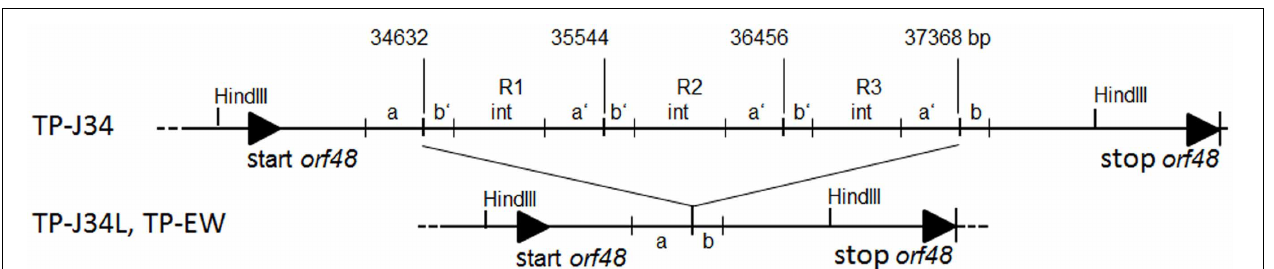
FIGURE 4 | Comparison of the genetic structure of the TP-J34 DNA region containing the triple repeat sequences R1–R3 with that of TP-J34L and TP-EW, respectively. The bp numbers indicate the first bp of a repeat. “a” and “b” denote the regions with similarities to sequences within